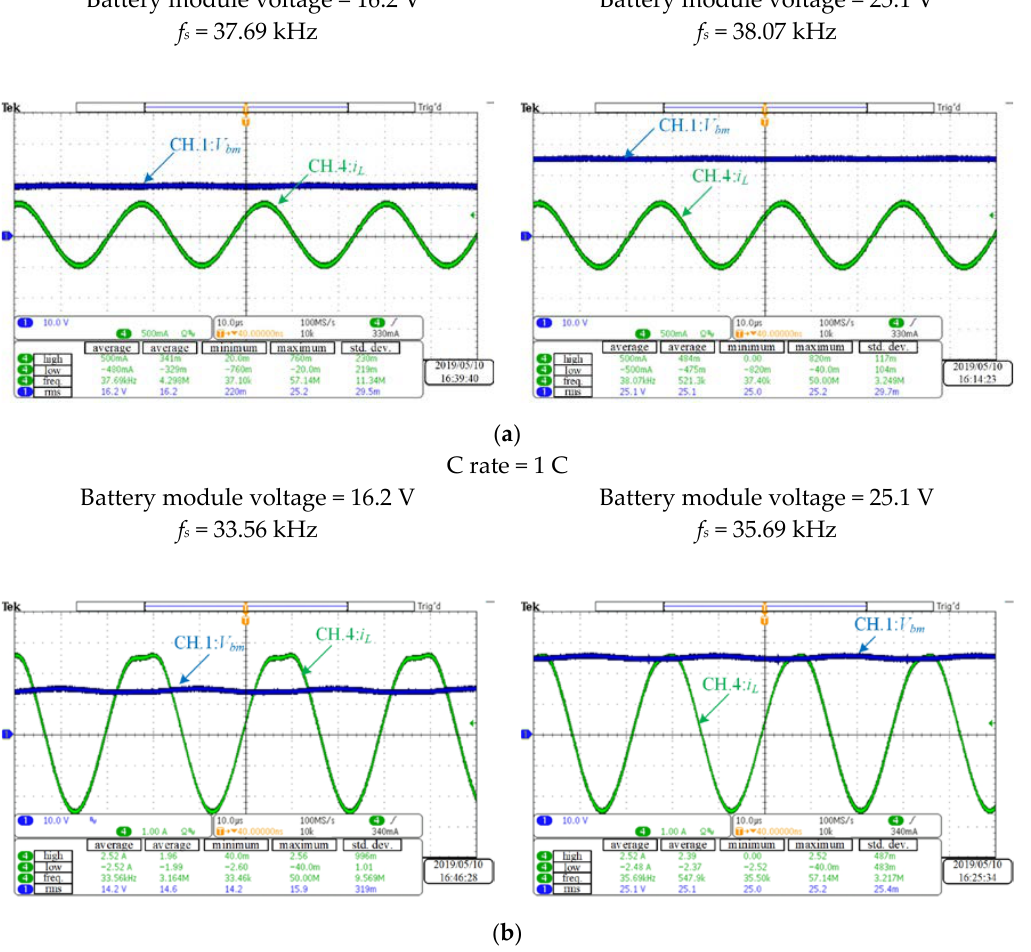
Figure 13. A comparison between the minimum battery module voltage and maximum battery module voltage under various load conditions: ( a ) C rate = 0.2 C; ( b ) C rate = 1 C.